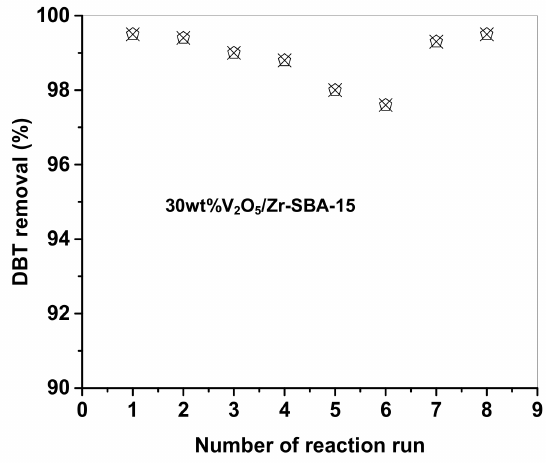
Figure 10. Reusability test of the 30 wt% V 2 O 5 /Zr-SBA-15 catalyst. Reaction condition: catalyst loading: 1 g/L oil; H 2 O 2 /DBT molar ratio: 10; reaction temperature: 60 ◦ C; reaction time: 60